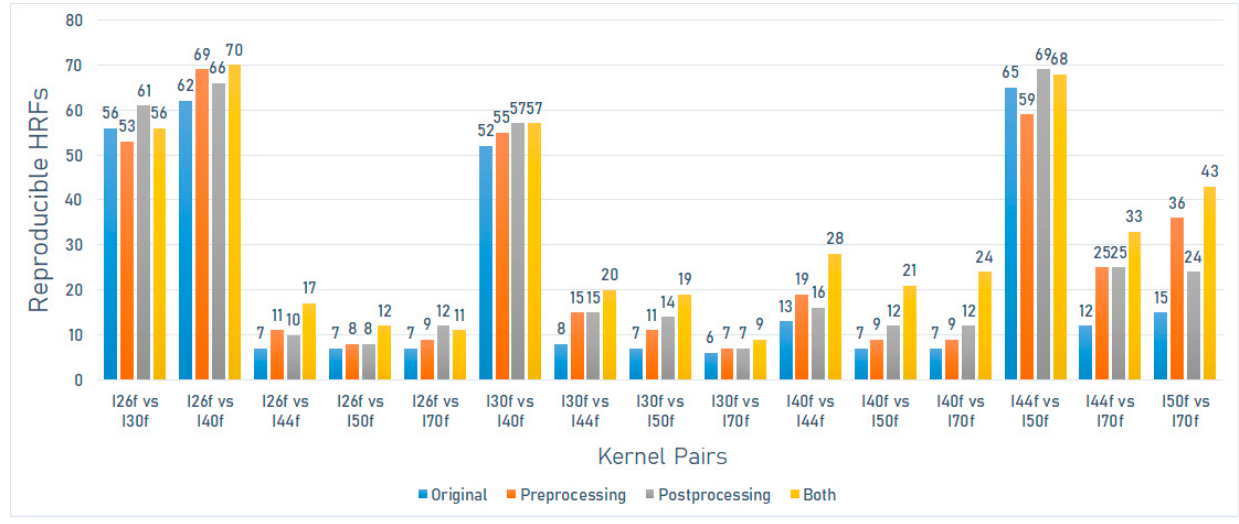
Figure 4. The number of reproducible HRFs across different kernels on the SOMATOM Definition scanner model.